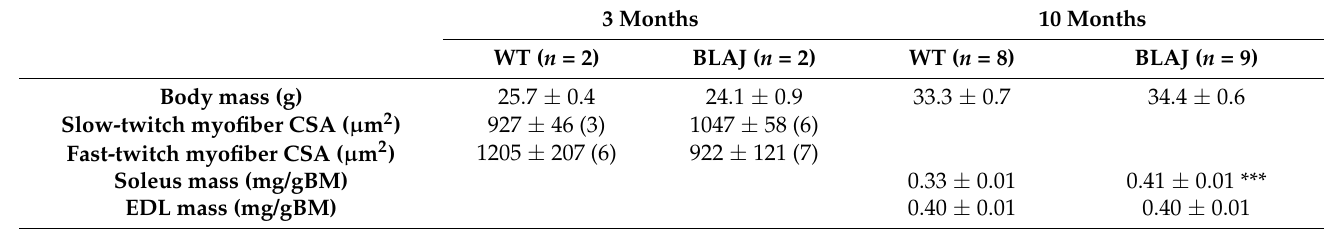
Table 1. Body mass and relevant tissue characteristics for normal wild-type (WT) and dysferlin- deficient BLAJ mice aged 3 and 10 months. Data analyzed by Student’s t -test: *** BLAJ vs WT ( p < 0.001), except for 3-month body mass data that were analyzed by Mann-Whitney U test. Data are presented as mean ± standard error of mean (SEM). For isolated myofibers from 3-month- old mice, values in brackets indicate the number of myofibers analyzed. Data for 10-month mice were previously reported by Lloyd et al. [26] (CC BY 4.0). Abbreviations: BM: body mass; CSA: cross-sectional area; EDL: extensor digitorum